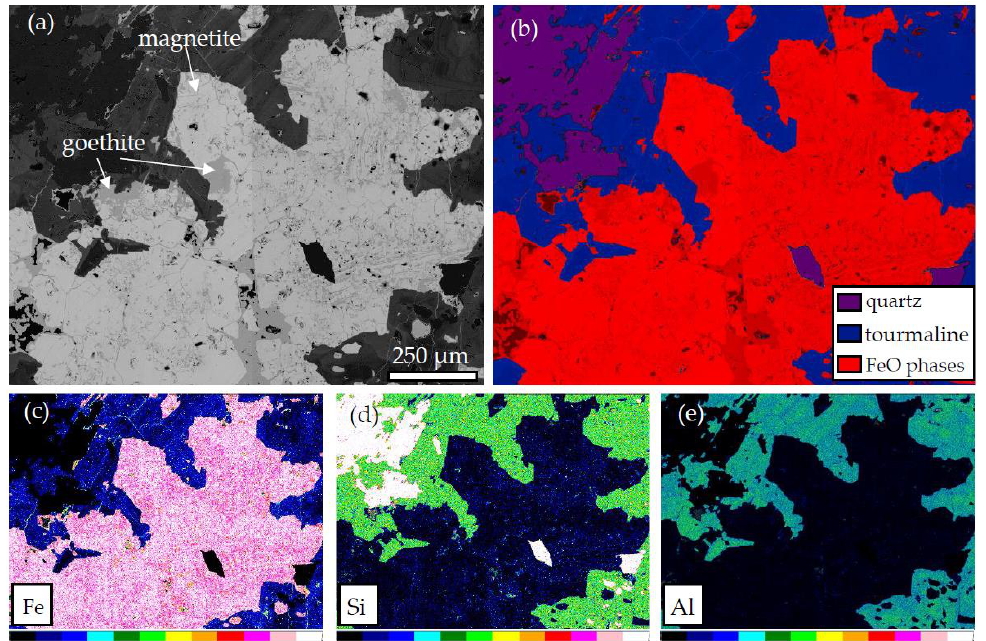
Figure 7. SEM maps of the selected area. ( a ) BSE montage map (4 frames 70×); ( b ) phase map in false color; ( c ) quantitative EDS map of Fe; ( d ) quantitative EDS map of Si; ( e ) quantitative EDS map of Al (same area but the images are all upside down).